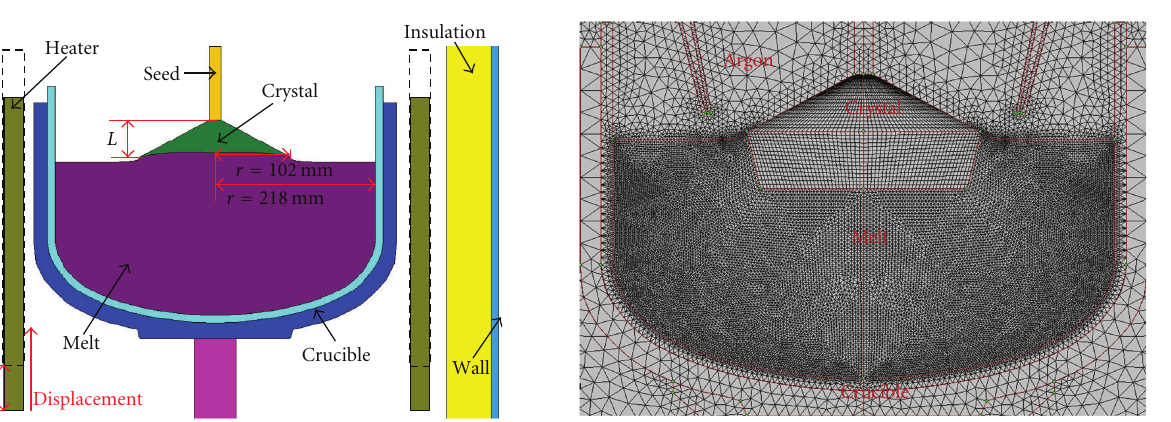
Figure 1: Schematic diagram of the major components of the CZ furnace, where L and h are the crystal length and the relative posi- tion of the heater in relation to the original position, respectively.